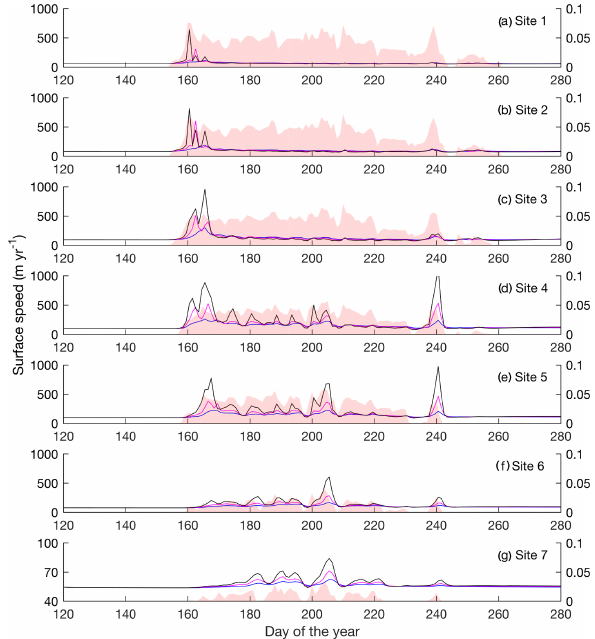
Figure 9. Modelled ice velocities using a Budd Sliding law plotted for the 2011 melt season (blue), the 2 × melt scenario (magenta), and for the 4 × melt scenario